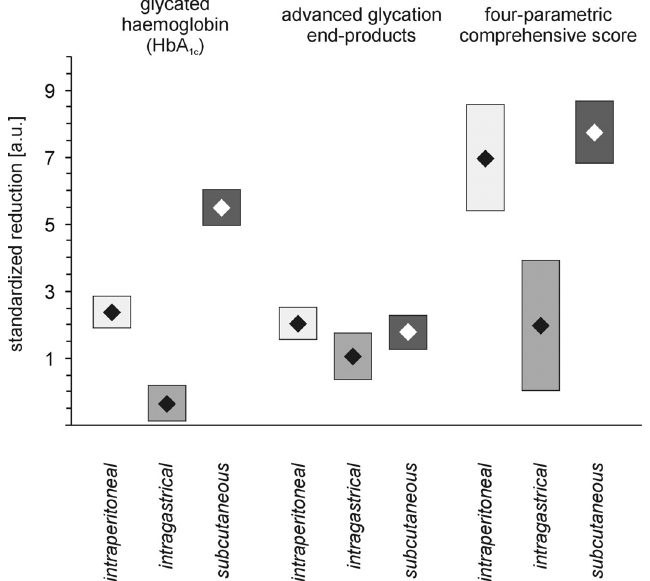
Figure 7. PAMAM G4 dendrimer-induced reductions in markers of hyperglycaemia in streptozotocin-diabetic rats treated with PAMAM G4 using various routes of